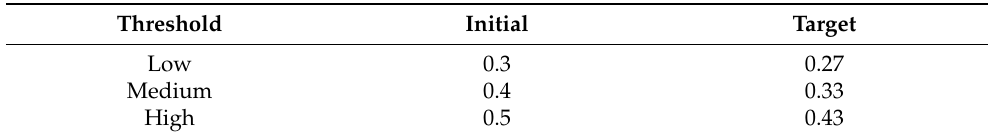
Table 1. Initial vs. Target